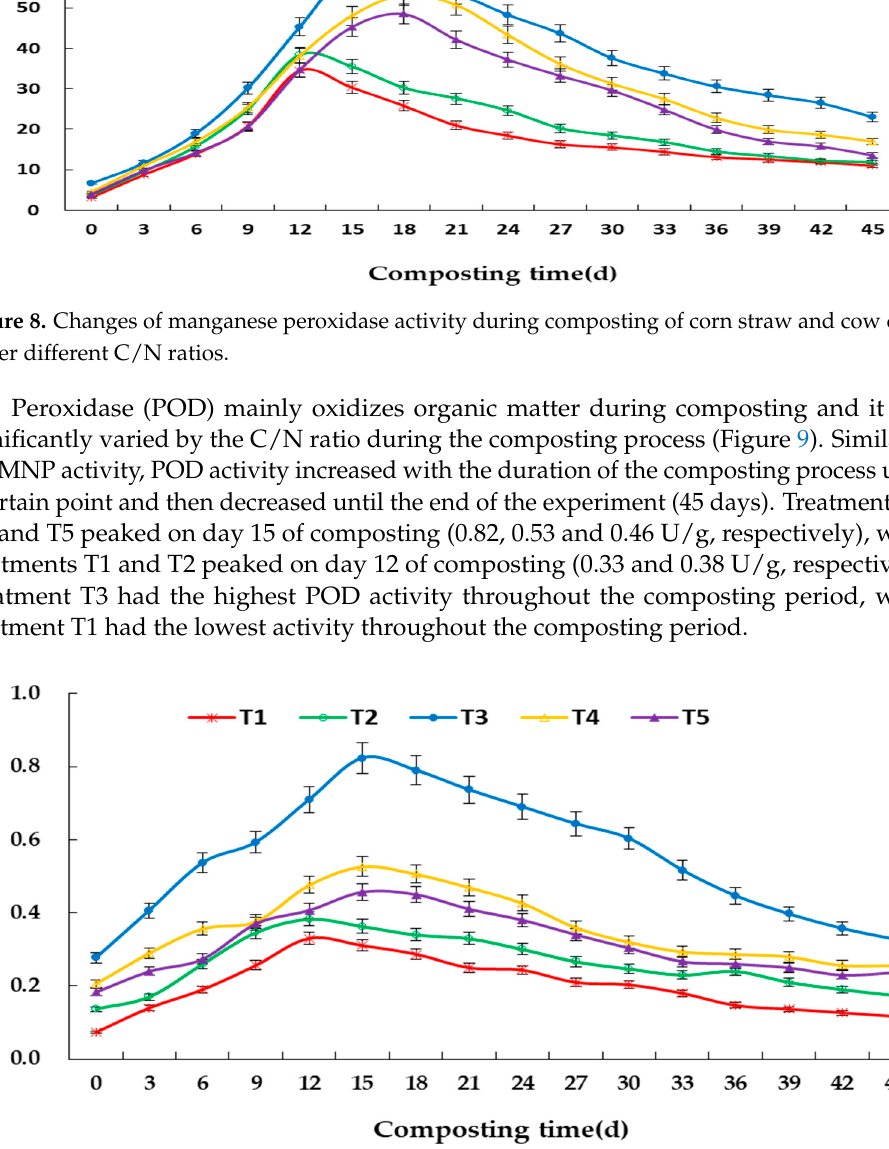
Figure 7. Changes of polyphenol oxidase activity during composting of corn straw and cow dung under different C/N ratios.